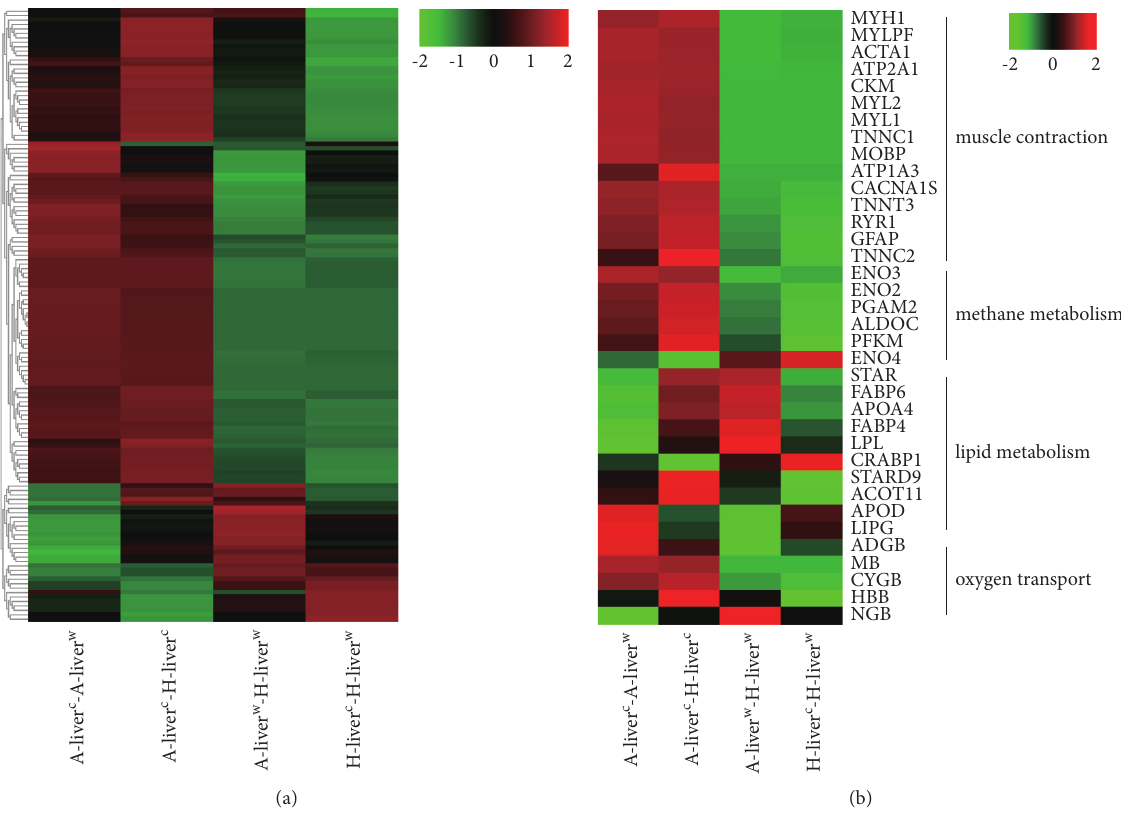
Figure 3: The heatmap of DEGs in the liver. A-liver c -A-liver w : liver of − 5 ° C Altay lambs ( n � 5) compared to 20 ° C Altay lambs ( n � 4); H-liver c -H- liver w :liverof − 5 ° CHulambs( n � 6)comparedto20 ° CHulambs( n � 4);A-liver c -H-liver c :liverof − 5 ° CAltaylambscomparedto − 5 ° CHulambs;A- liver w -H-liver w : liver of 20 ° C Altay lambs compared to 20 ° C Hu lambs. (a) A heatmap of top 50 DEGs. (b) A heatmap of candidate DEGs. The cluster analysis of gene expression is based on log2 FPKM data. The red color represents higher expression, and the green color represents lower